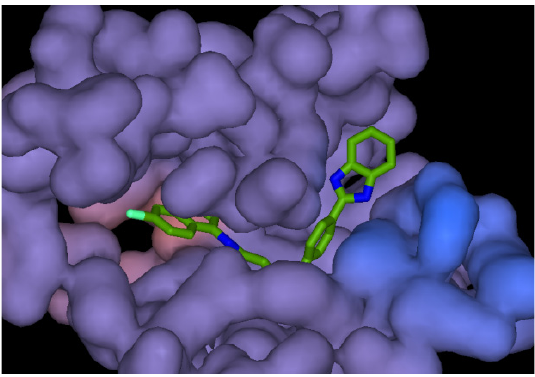
Figure 6. Segment of c-Src active site cleft with docked compound 12d .